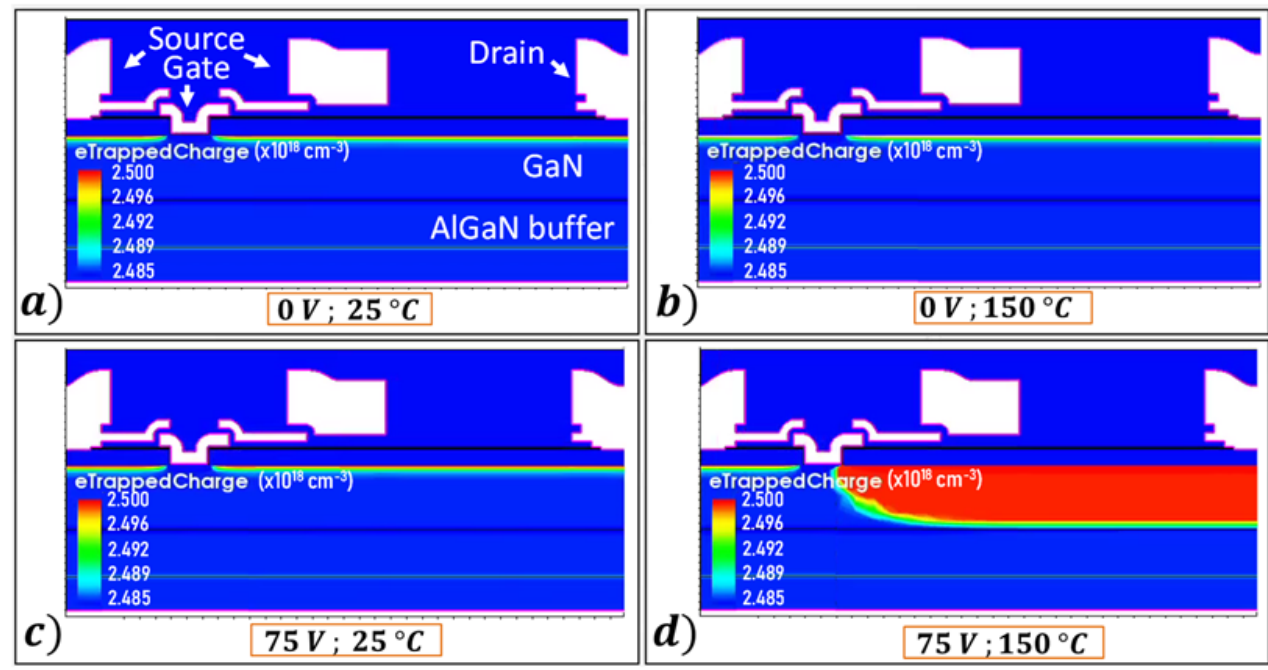
Figure 6. TCAD acceptor trap ionization mapping of the split 2 (E A ‐ E V = 0.9 eV) with the lower tick parameter of the colored scale equal to the concentration of the donor traps at ( a ) V GS = ‐ 2 V; V DS = 0 V; T = 25 °C ( b ) V GS = ‐ 2 V; V DS = 0 V; T = 150 °C ( c ) V GS = ‐ 2 V; V DS = 75 V; T = 25 °C ( d ) V GS = ‐ 2 V; V DS = 75 V; T = 150 °C.